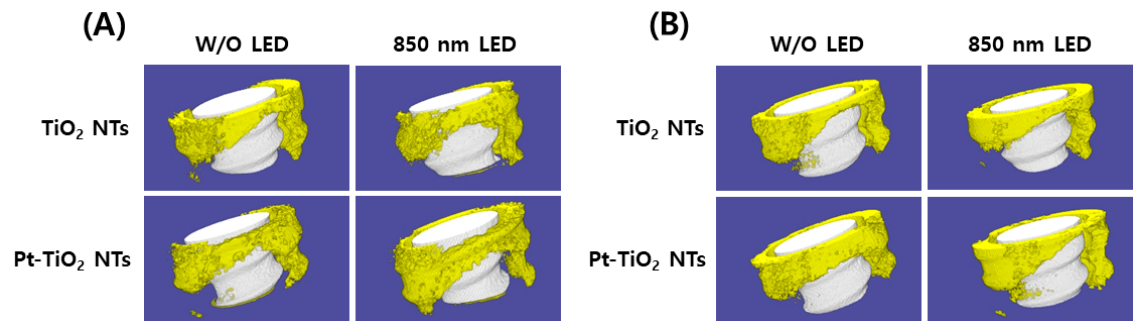
Figure 8. Three-dimensional micro-CT images and analysis of TiO 2 NT- and Pt-TiO 2 NT-treated implants after ( A ) two and ( B ) six weeks of implantation (white color: TiO 2 NT or Pt-TiO 2 NT surface-treated implant, yellow color: bone).